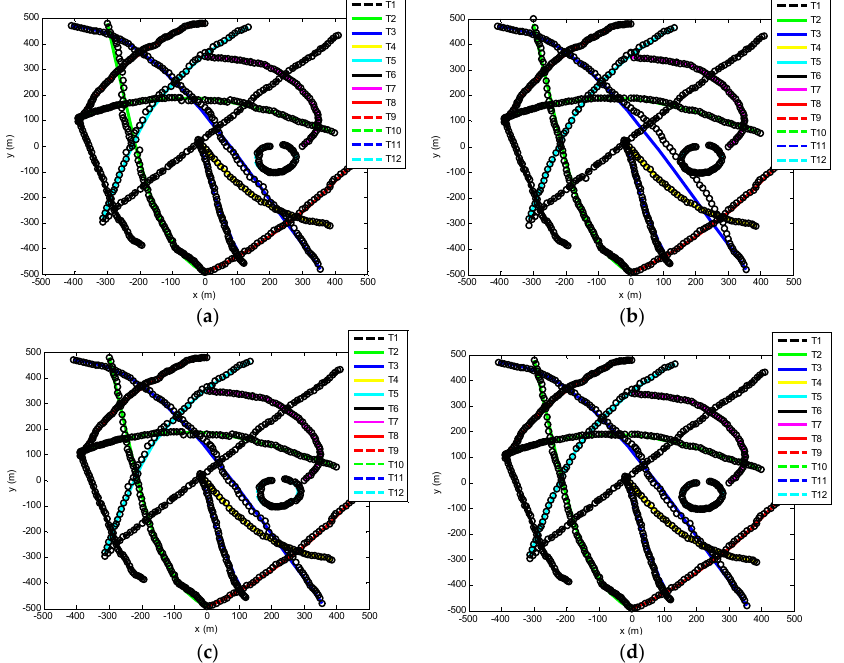
Figure 3. Position estimation: black circles are the real track points. ( a ) BGM–PMBM; ( b ) IGGM–PHD; ( c ) BGGIW–PMBM; ( d ) IGGM–PMBM.